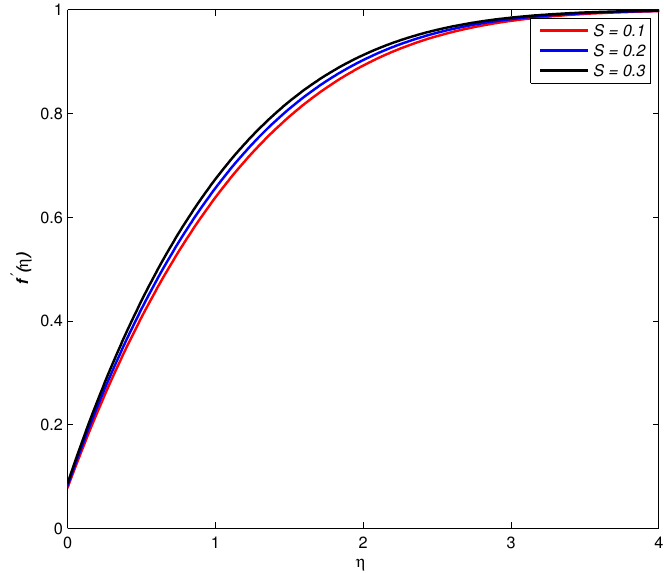
Figure 14. Velocity f (cid:48) ( η ) profiles for different values of suction parameter S >